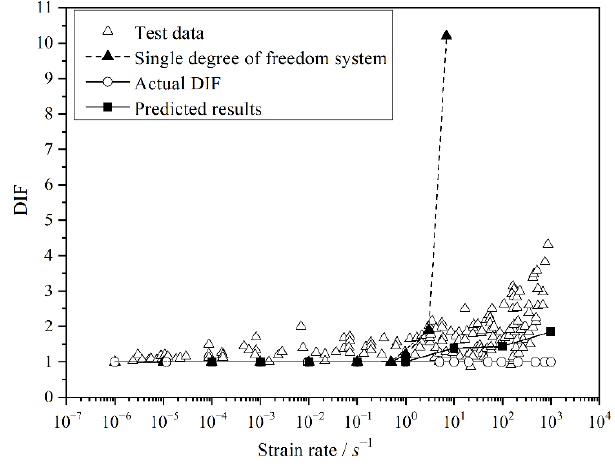
Figure 7. Simulation results of concrete dynamic compressive strength.